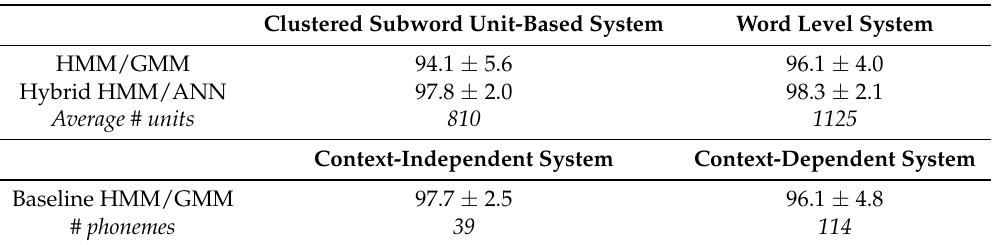
Table 1. Clustered subword unit-based and word level systems RA on the PhoneBook database using PLP cepstral features with HMM/GMM and hybrid HMM/ANN systems.